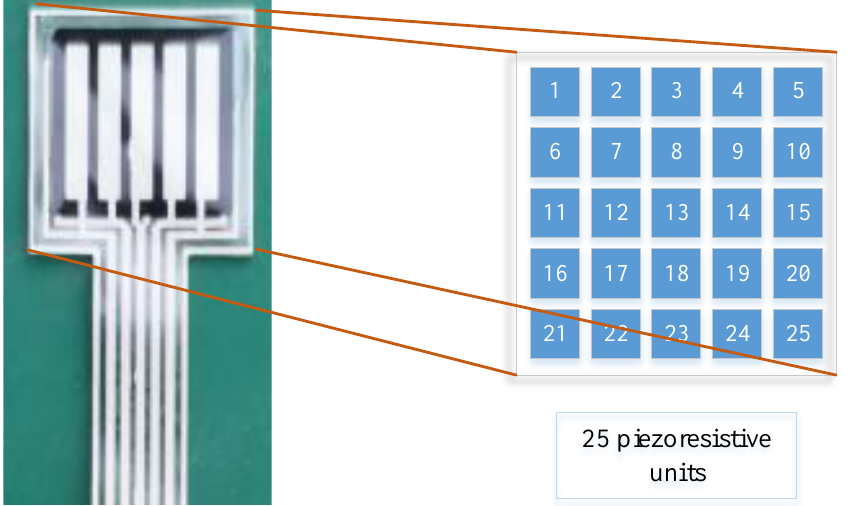
Figure 3. Distribution of each piezoresistive unit of the tactile